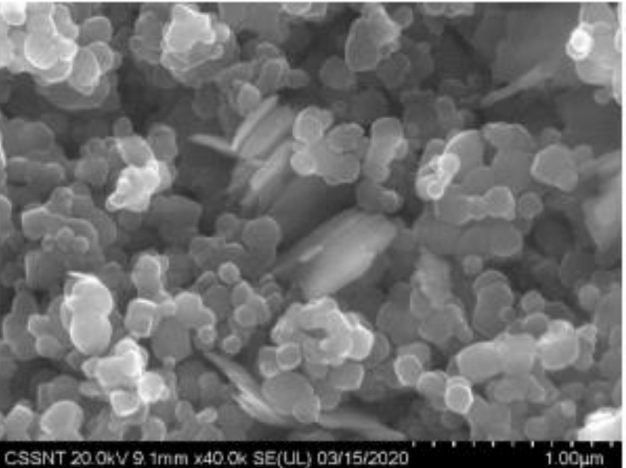
Figure 7. SEM micrographs of 2% copper-doped TiO 2 pigment